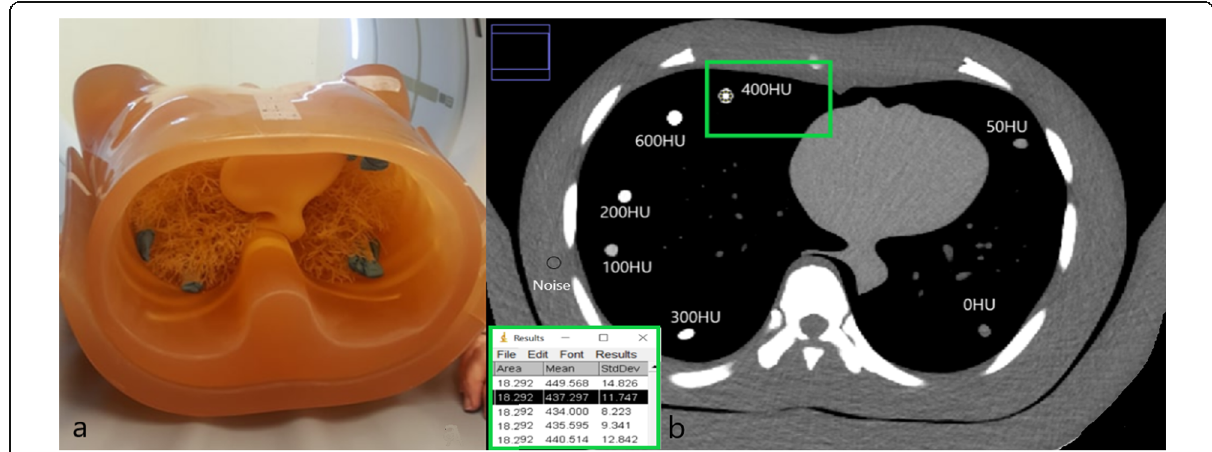
Fig. 1 a Kyoto Kaguka Lungman Phantom (medium size) displaying the seven straws. b A single computed tomography (CT) image acquired using the phantom. This image includes the seven straws containing different iodine densities, resulting in specific HU values at 120 kVp when